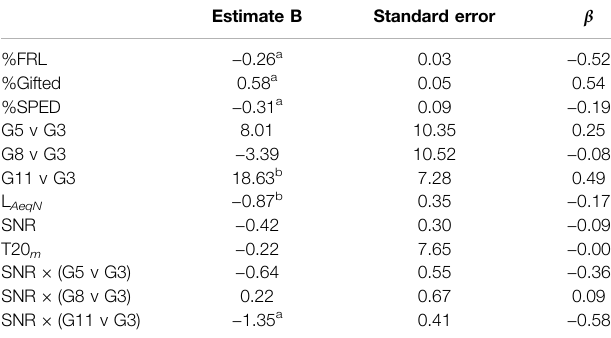
TABLE 4 | Results from the multivariate regression model ( N (cid:1) 178) with acoustic metrics as predictors, classroom demographic variables as covariates, and math test scores as outcomes. Grade results shown are against grade 3.